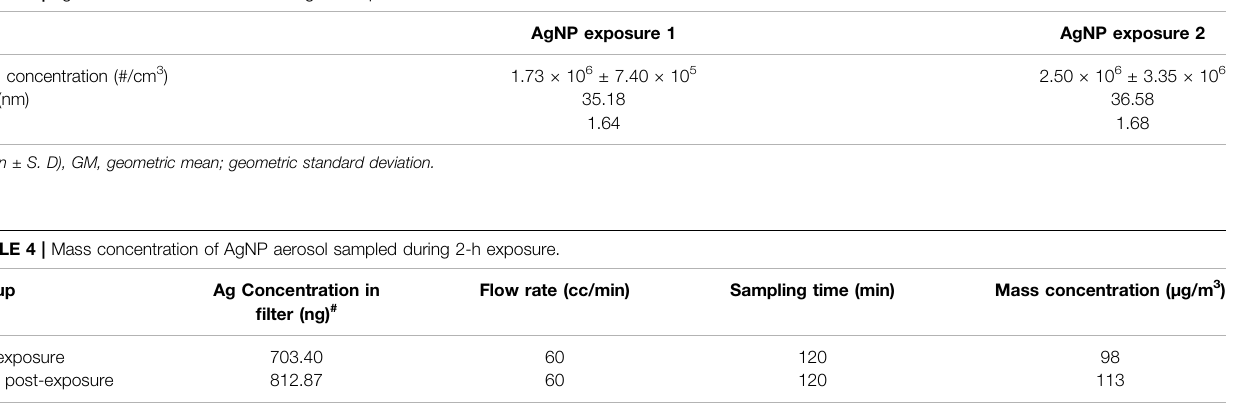
TABLE 3 | AgNP aerosol concentration during 2-h exposure.